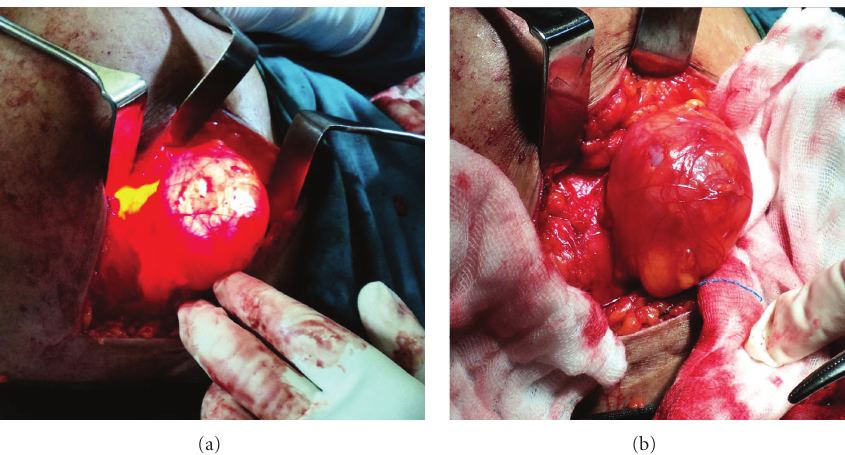
Figure 3: The external view of Spigelian hernia sac with (a) and without (b) transillumination with the laparoscope’s light